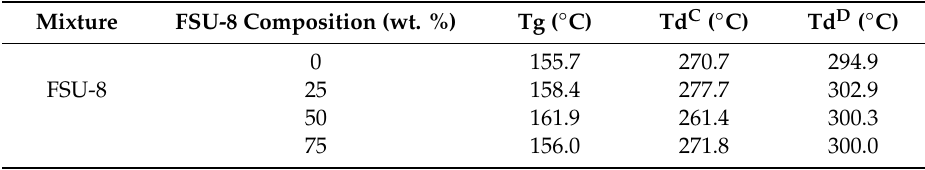
Table 1. Thermal properties of materials with different content of FSU-8.